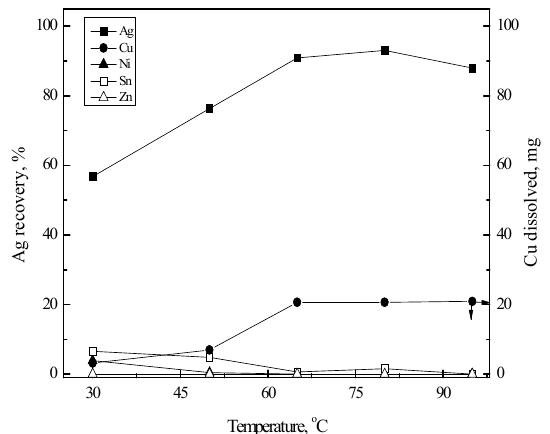
Figure 8. Effect of temperature on the Ag recovery by cementation with Cu sheet. Stirring speed = 200 rpm; temperature = 30–95 °C; time = 60 min; copper sheet = 50 × 12.5 mm 2 .